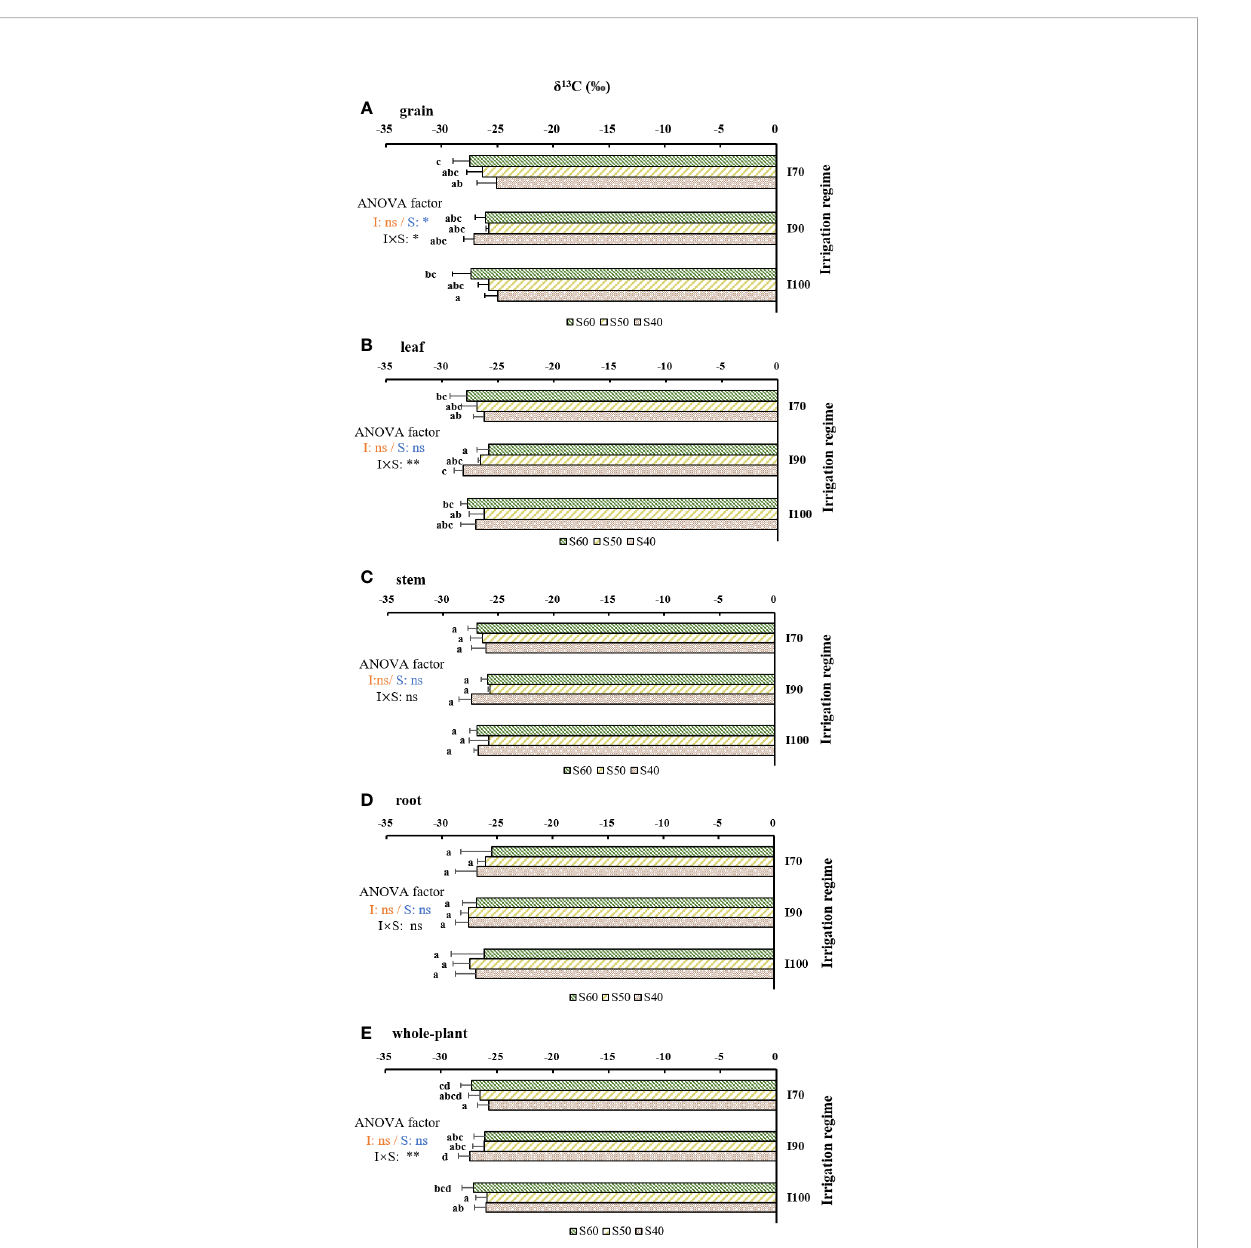
FIGURE 3 The effects of treatments and output of two-way analysis of variance (ANOVA) for d 13 C values in (A) grain, (B) leaf, (C) stem, (D) root and (E) whole-plant as in fl uenced by different water regimes and soil clay contents (mean ± SD; n = 4). I 70 , I 90 and I 100 represent irrigation regimes of fl ooding with 30mm (upper limit) as the soil water reaches 70% of saturation (lower limit); fl ooding with 30mm (upper limit) as the soil water reaches 90% of saturation (lower limit) and fl ooding with 30mm (upper limit) as the soil water reaches 100% of saturation (lower limit). S 40 , S 50 , and S 60 indicate soil clay content with 40%, 50% and 60% respectively. Different letters mean signi fi cant differences ( p <0.05). I, S, and I×S indicate irrigation regime, soil type, and the interaction between irrigation regime (I) and soil type (S), respectively. ns, *, ** and represent no signi fi cance, 0.01< p <0.05, and p <0.01,